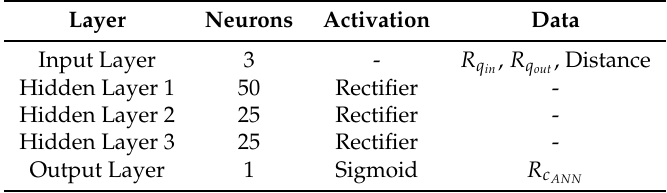
Table 5. ANN model definition with layers, activation function and data.